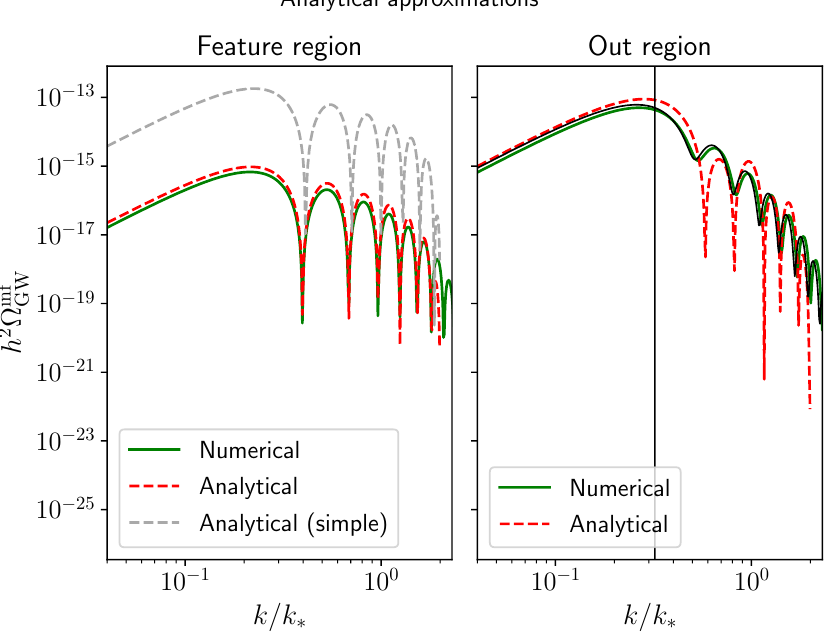
Figure 6 . Comparison between analytical approximations and full numerical results for different contributions to Ω inf in the explicit scenario of section 4.7 with parameters ( δ, η ⊥ ) = (0 . 5 , 14) . On GW the left-hand side the contribution from the region of the feature (green), versus the approximations in eq. (4.61) (dashed red) and in eq. (4.62) (dashed gray). On the right-hand side the dominant contribution from the out region (green) versus the analytical approximation in eq. (4.47) (dashed red) which, quite remarkably, provides a very good estimate of the overall shape, amplitude and frequency of the full Ω inf signal (black). Eventually, the vertical black line highlights the position GW of the global maximum found analytically in eq.